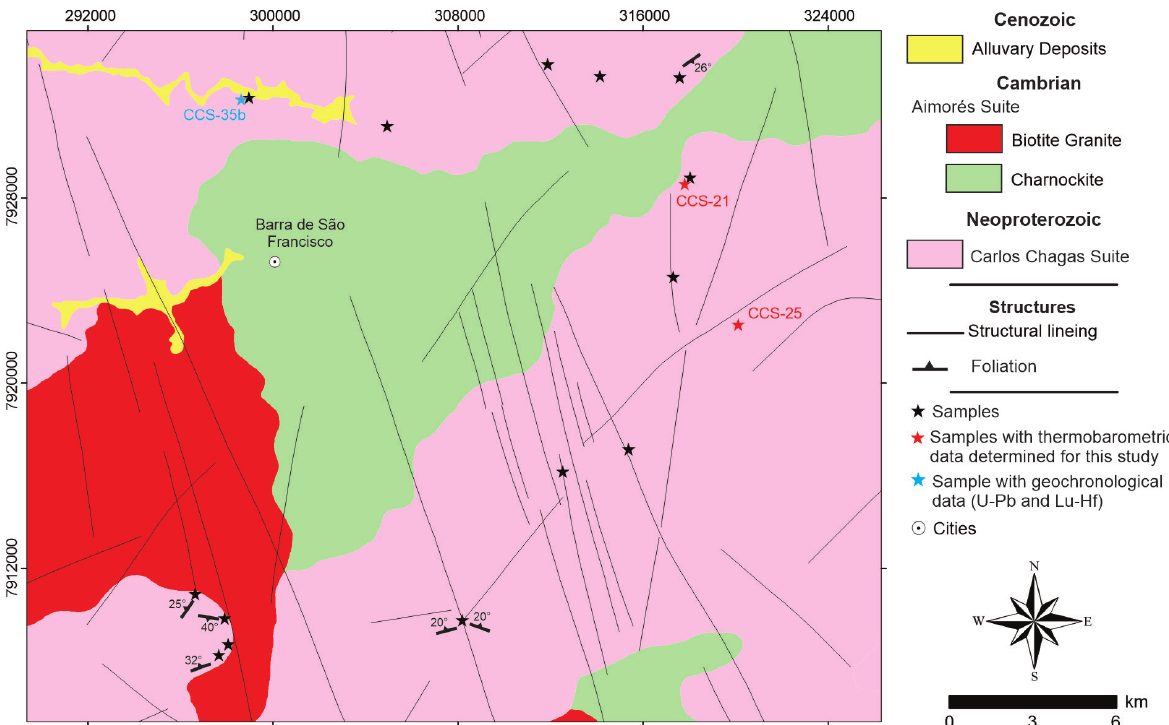
Figure 2. Simplified geologic map for study area, showing the location of samples (modified from Pedrosa-Soares et al.